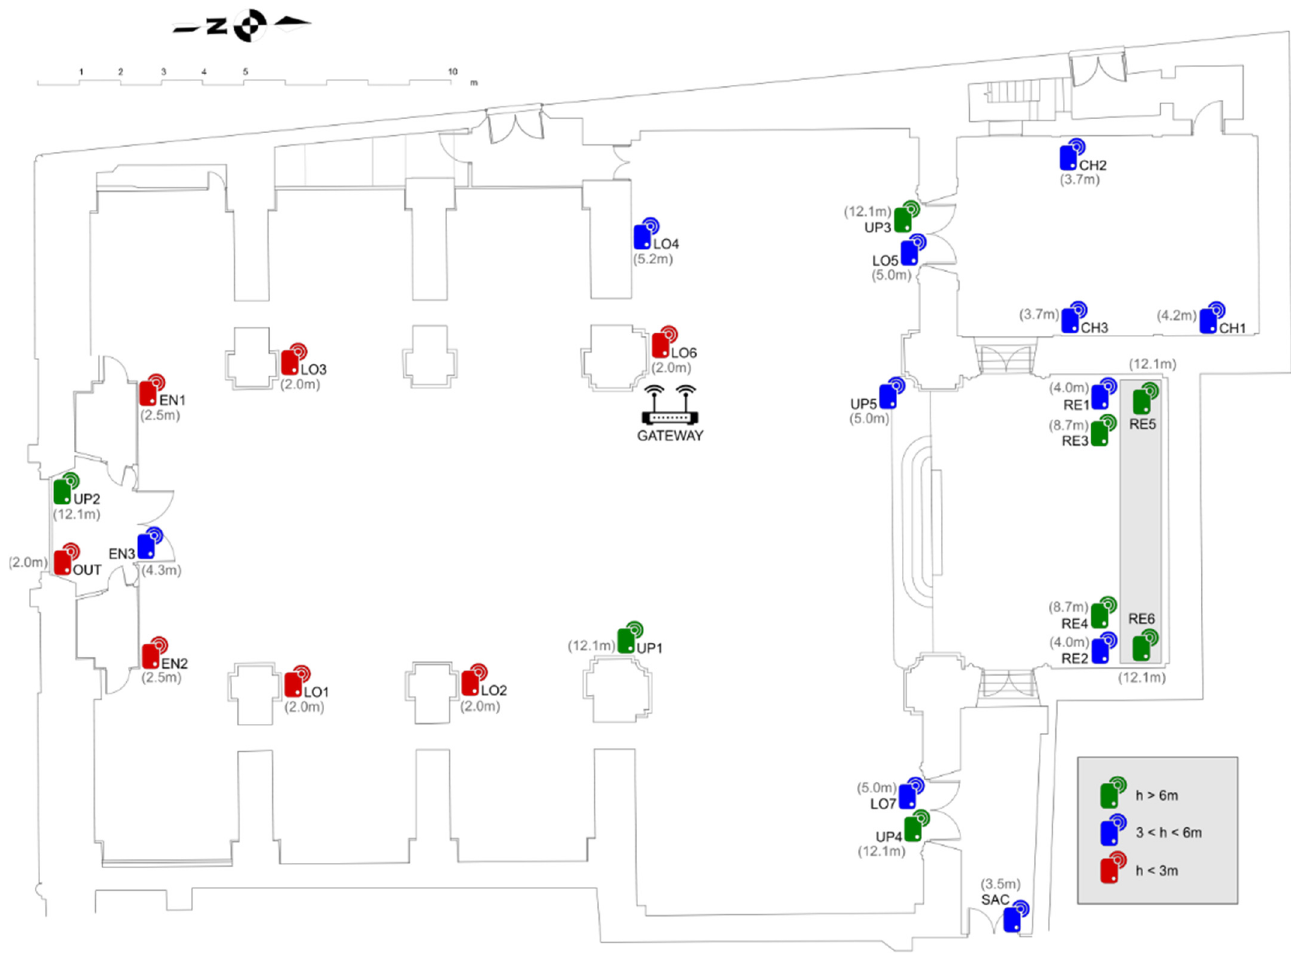
Figure 5. Position of the 26 nodes installed at the church of Saint Thomas and Saint Philip Neri (Valencia). Color codes according to their height (h): red (h < 3 m), blue (3 < h < 6 m), green (h > 6 m). The position of the sink gateway is indicated as SG. The retable is depicted in grey.